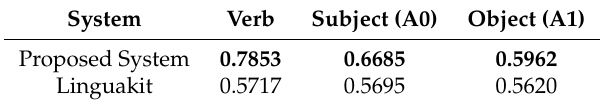
Table 12. Comparison of F1 score between the proposed system and Linguakit on Data set